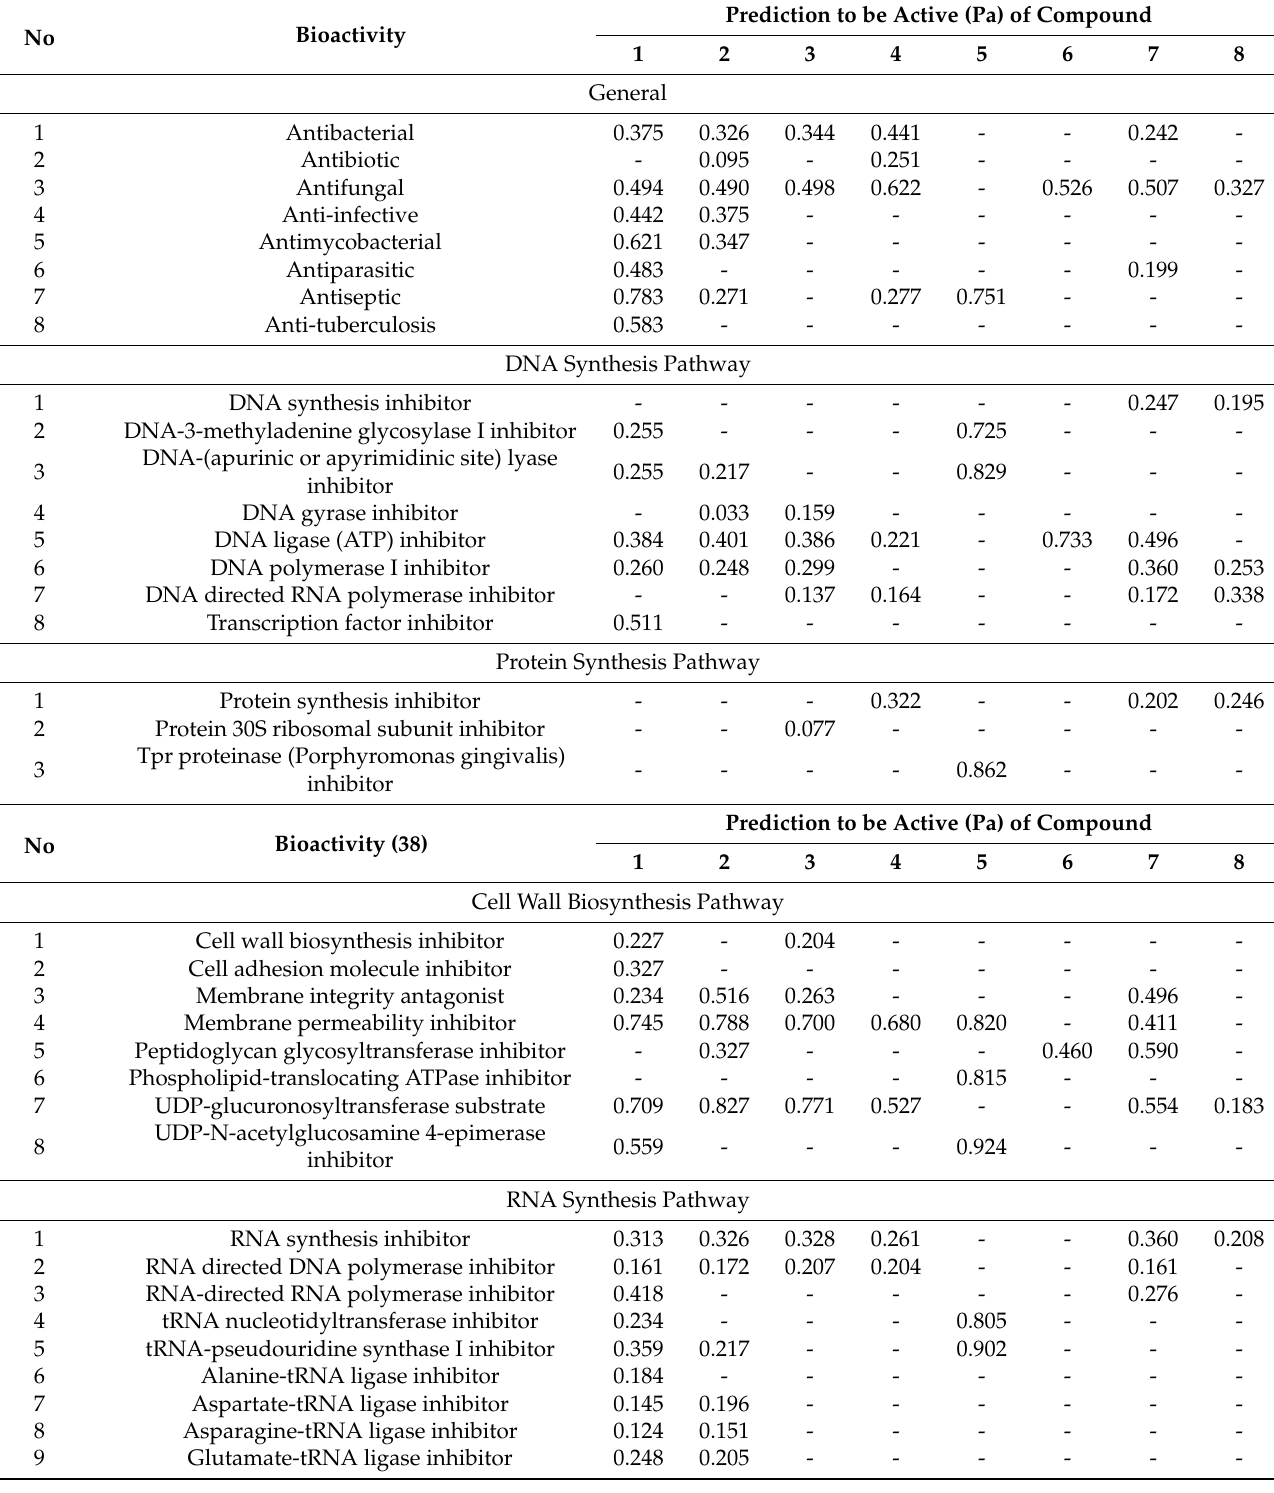
Table 1. Prediction activity of M. pendans compounds through PASS